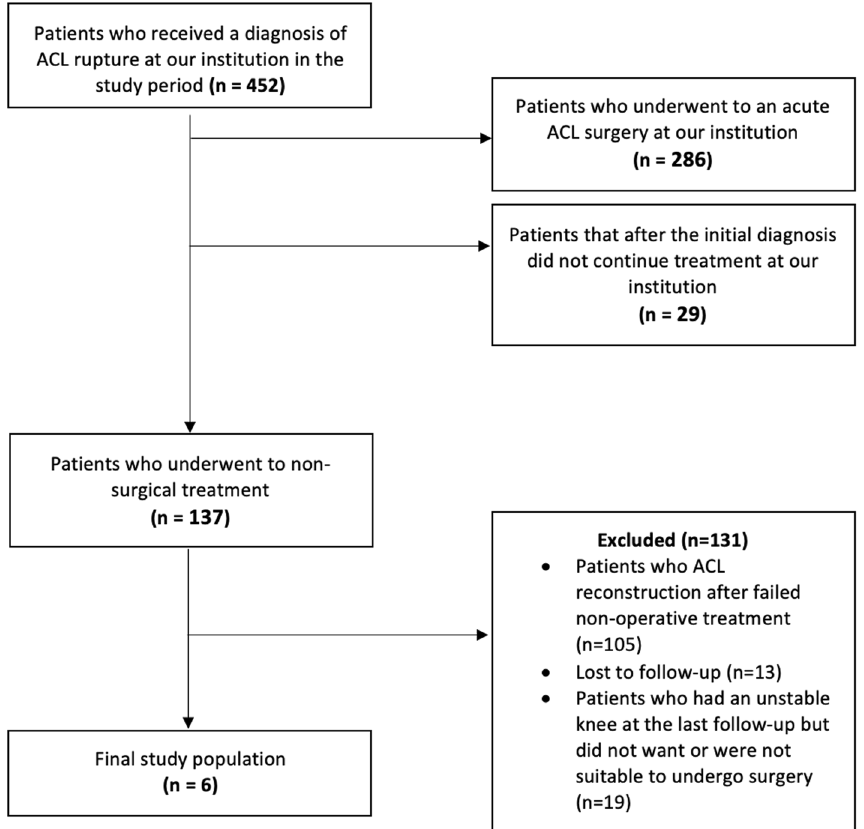
Fig. 1 The study flow chart in line with the STROBE (Strengthening the Reporting of Observational Studies in Epidemiology) statement (http:// www. strob estat ement. org). ACL, anterior cruciate